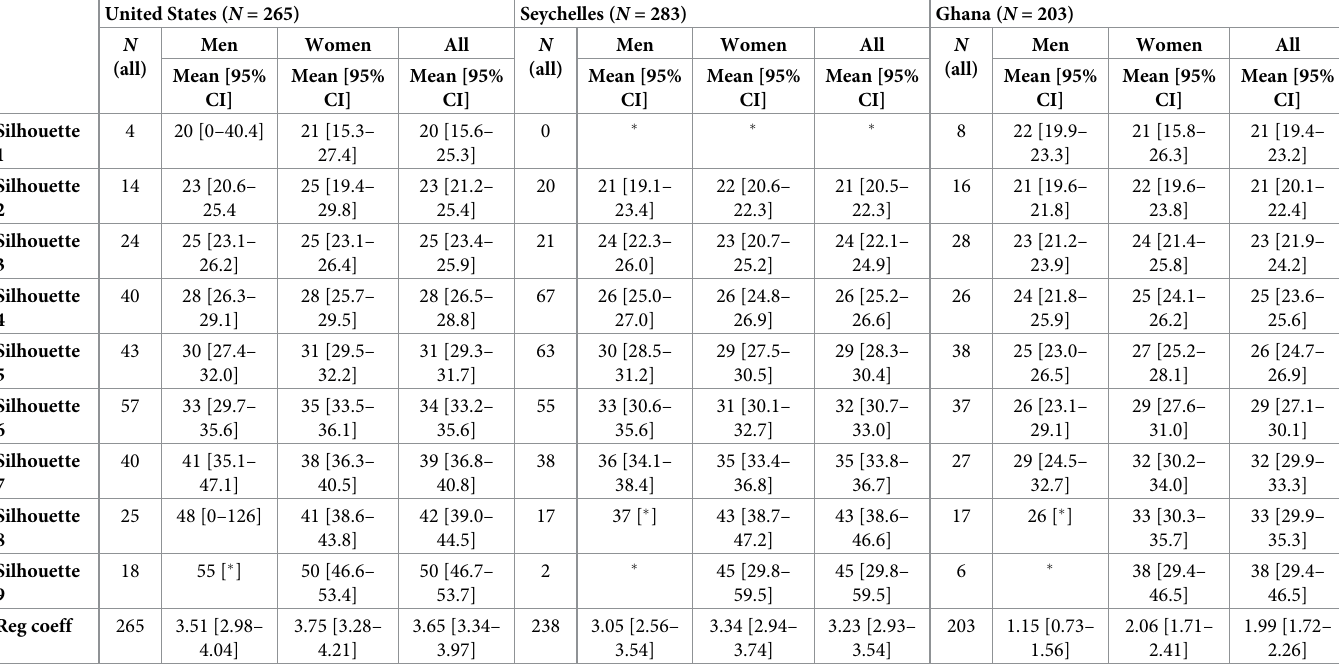
Table 3. Mean BMI by silhouette number, country, and sex.